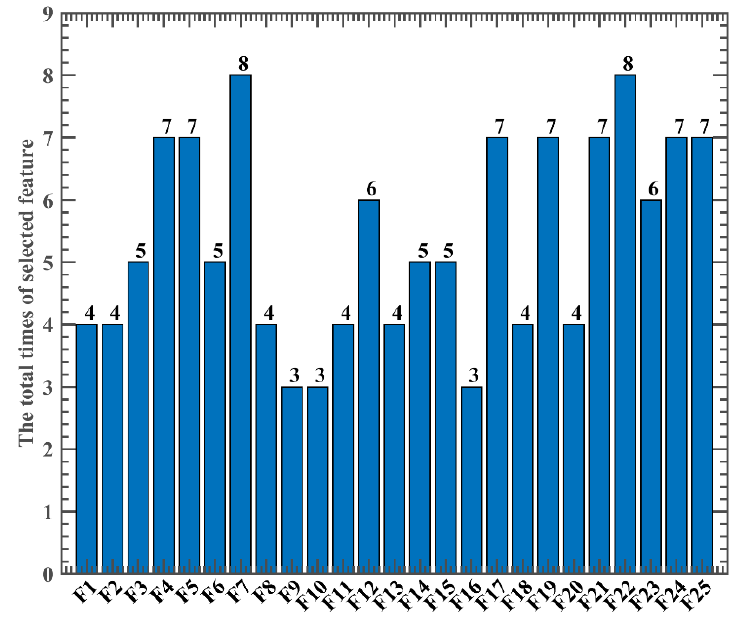
Figure 8. Feature selection results of the proposed model.